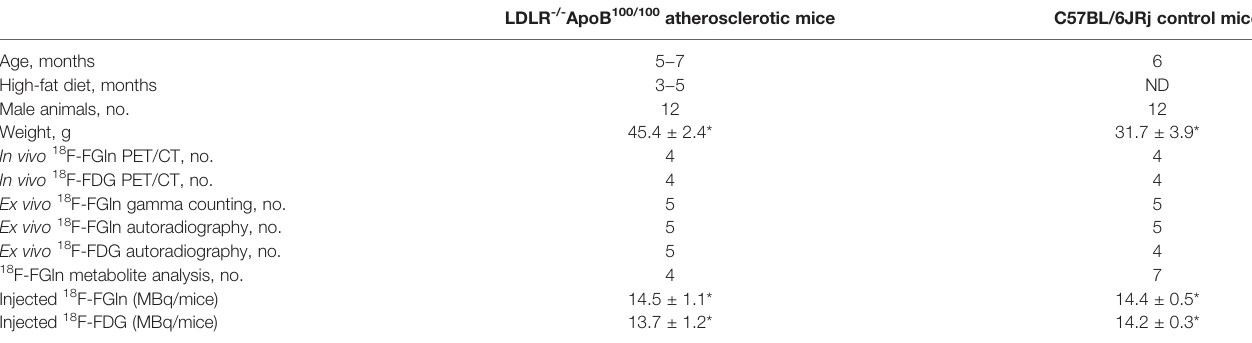
TABLE 1 | Characteristics of the investigated